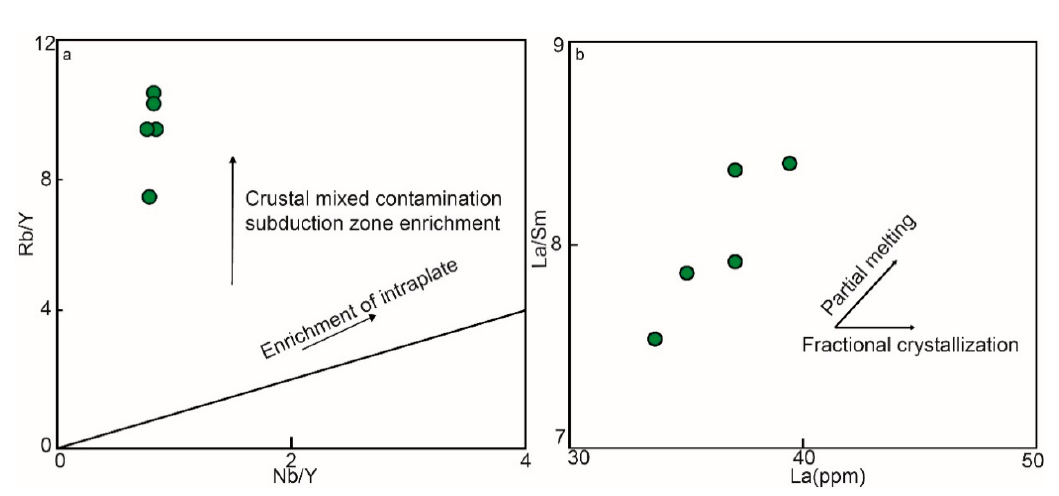
Figure 10. Harker diagram of SiO 2 versus other major elements of Hucunnan granodiorite: ( a ) SiO 2 vs. Al 2 O 3 , ( b ) SiO 2 vs. CaO, ( c ) SiO 2 vs. P 2 O 5 T, ( d ) SiO 2 vs. Na 2 O, ( e ) SiO 2 vs. TiO 2 , ( f ) SiO 2 vs. Mg.